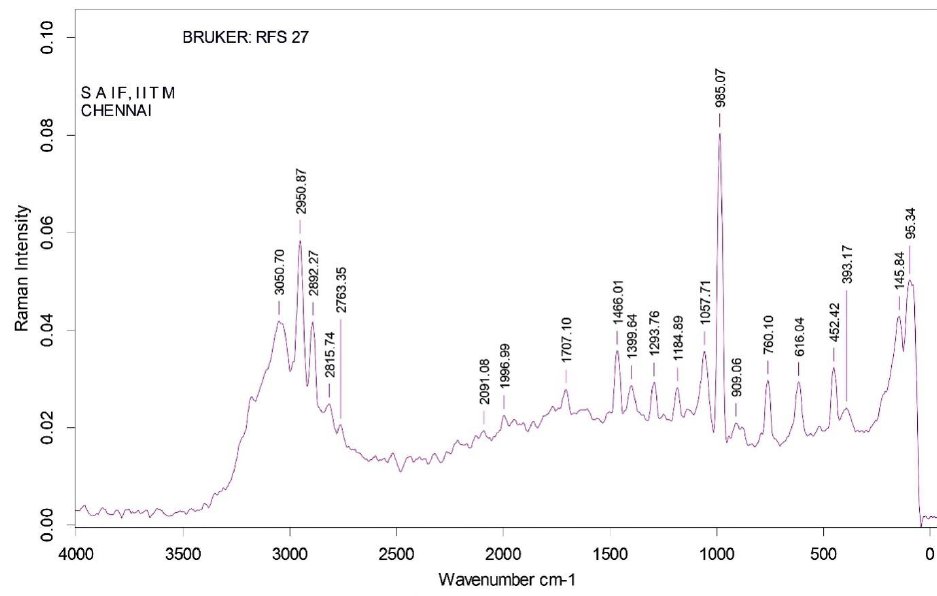
Figure 7. FT − R spectroscopy spectrum of hyaluronidase enzyme. FT Raman Band assignments of hyaluronidase in the region of 4000– 500 cm −1 .